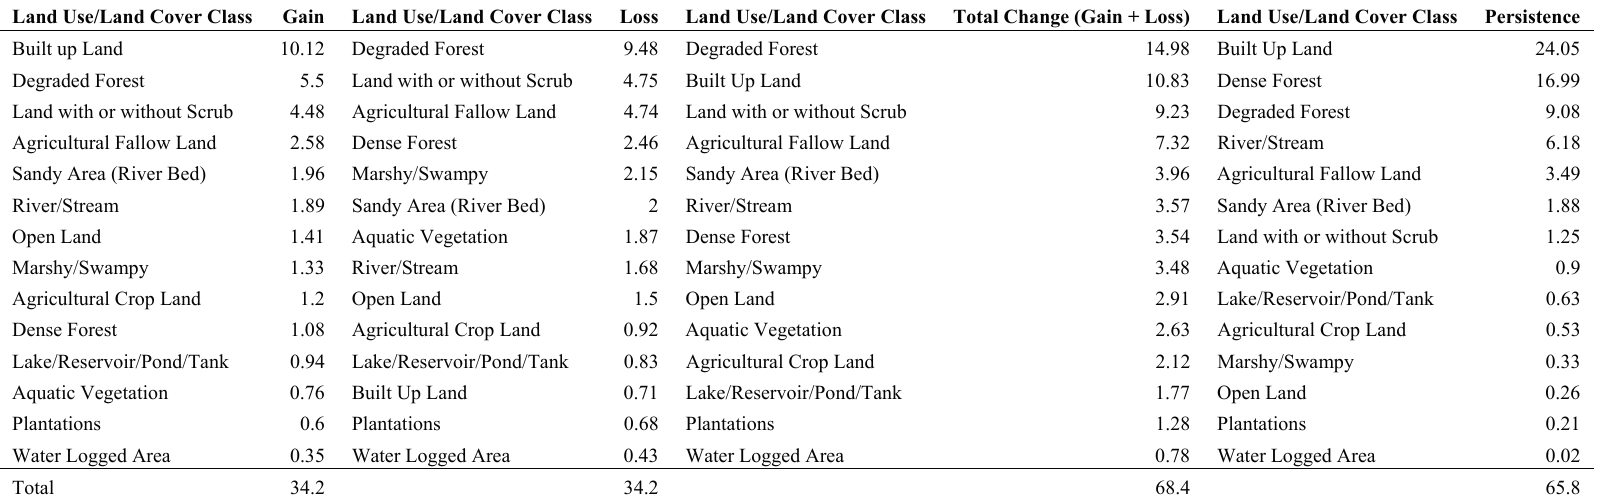
Table 12. Ranking, % gains, losses and persistence’s of LULC category between 1997 and